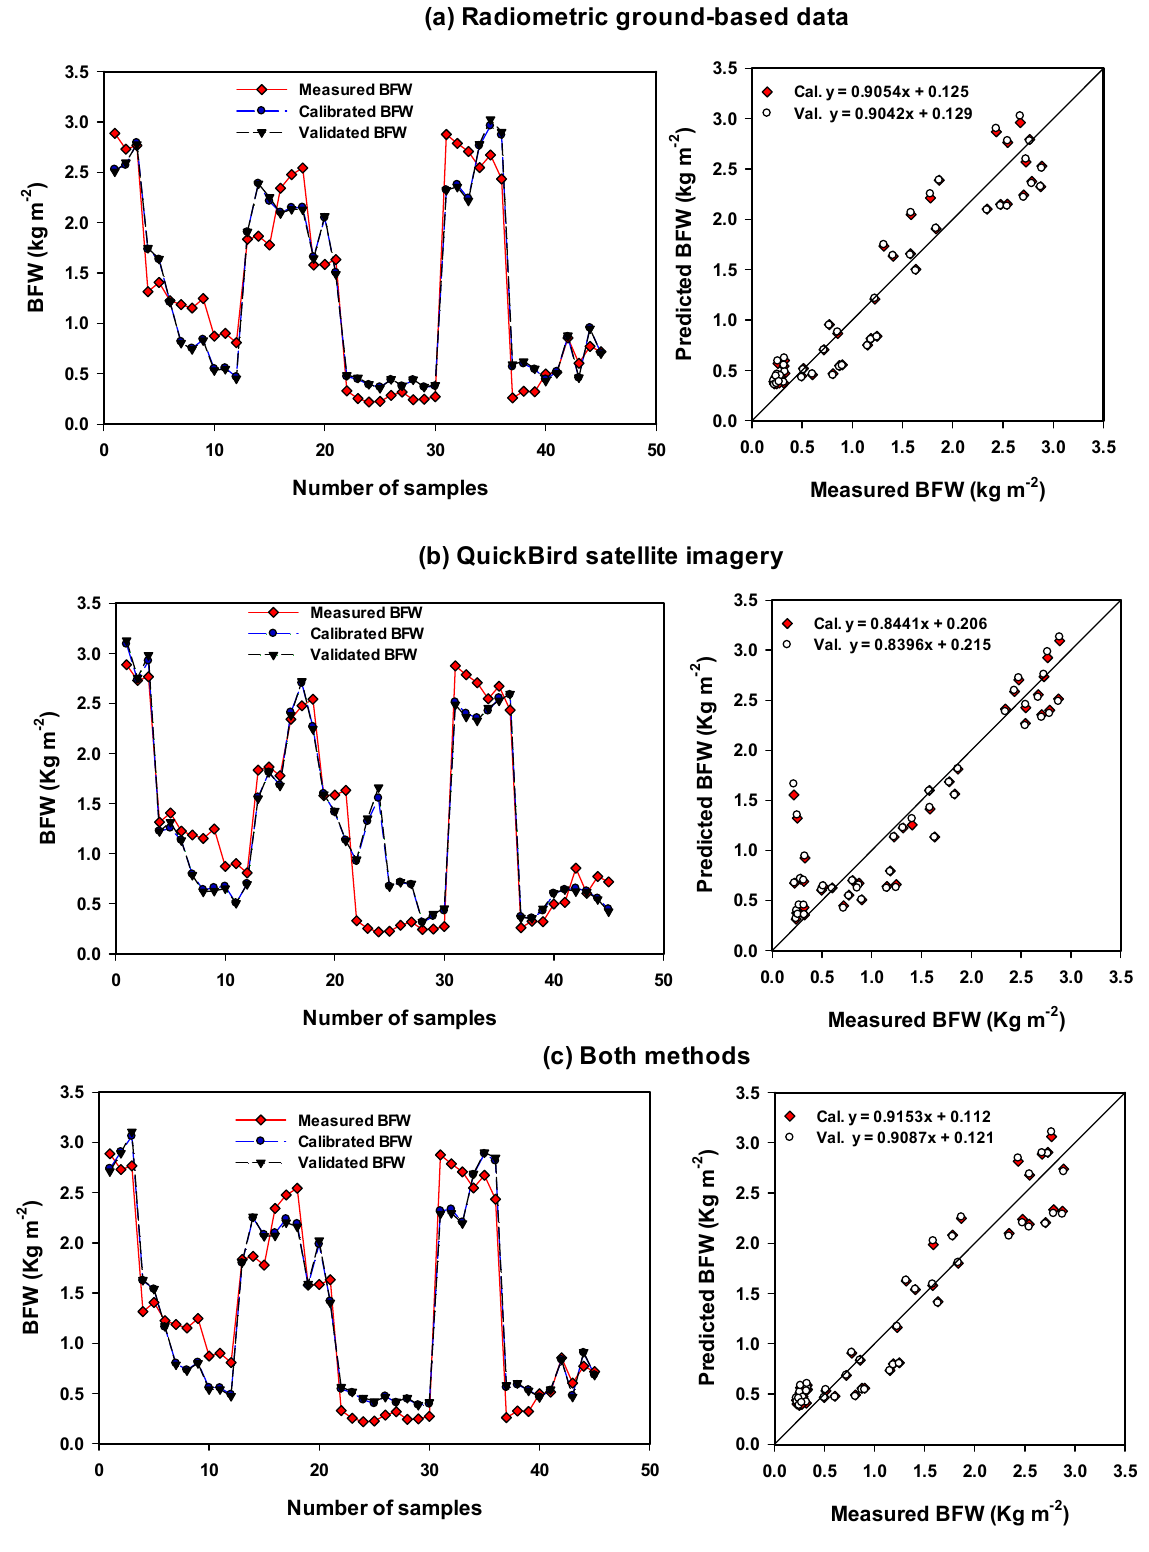
Figure 4. Comparison between measuring series, calibrating series and validating series for biomass fresh weight (BFW) of maize using the PLSR models based on selected vegetation-(SRIs) extracted from (a) radiometric ground-based data, (b) extracted from QuickBird satellite imagery, and (c) extracted from both methods.